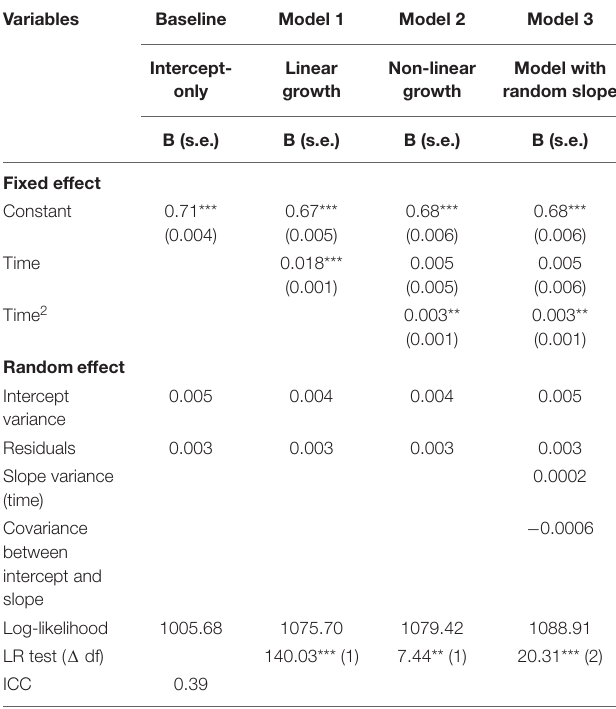
TABLE 5 | Cohort 2: results of ME growth model for changes in ANS accuracy from grade 5 to grade